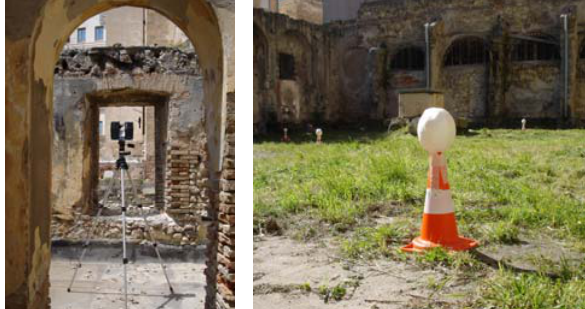
Figures 5 and 6: Outdoor scan. Signals for the georeferencing of the point